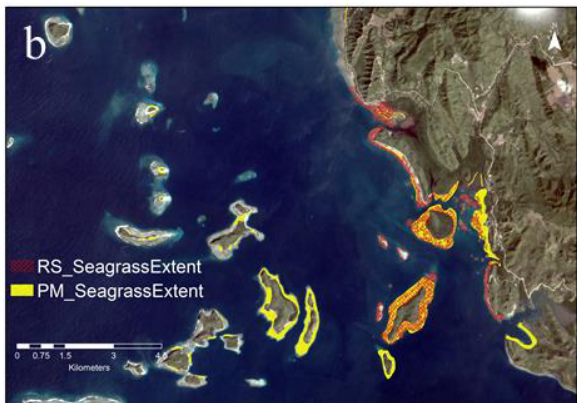
Figure 3. (a) Overlayed patches of mangroves obtained from participatory map (PM, yellow solid) and Sentinel-2 classified image (RS, red hatched); (b) Overlayed patches of seagrass meadows obtained from participatory map (yellow solid) PlanetScope classified image (red hatched).